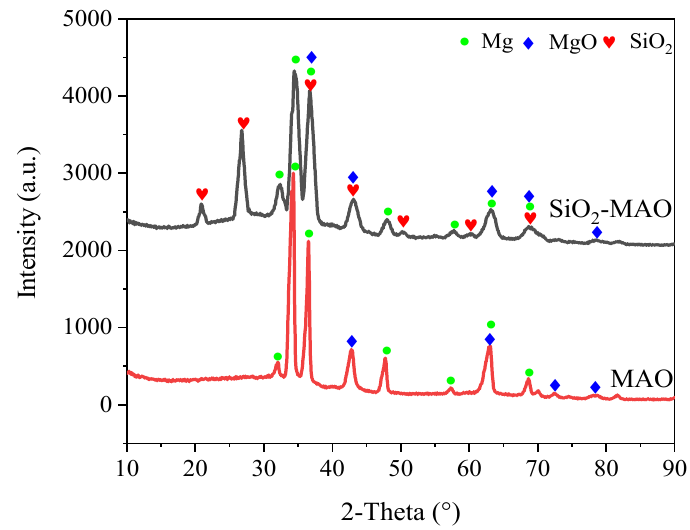
Figure 3. XRD scan results of the MAO coating and SiO 2 /MAO